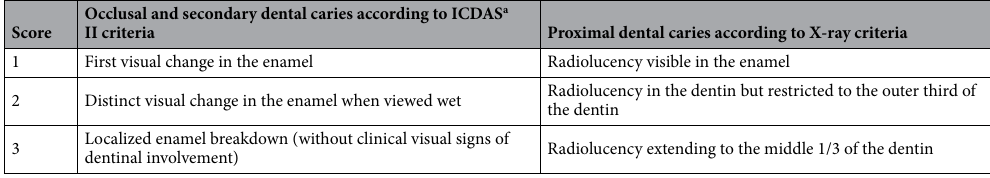
Table 5. Criteria for the evaluation for dental caries. a Quantitative light-induced fluorescence (QLF); International Caries Detection and Assessment System (ICDAS